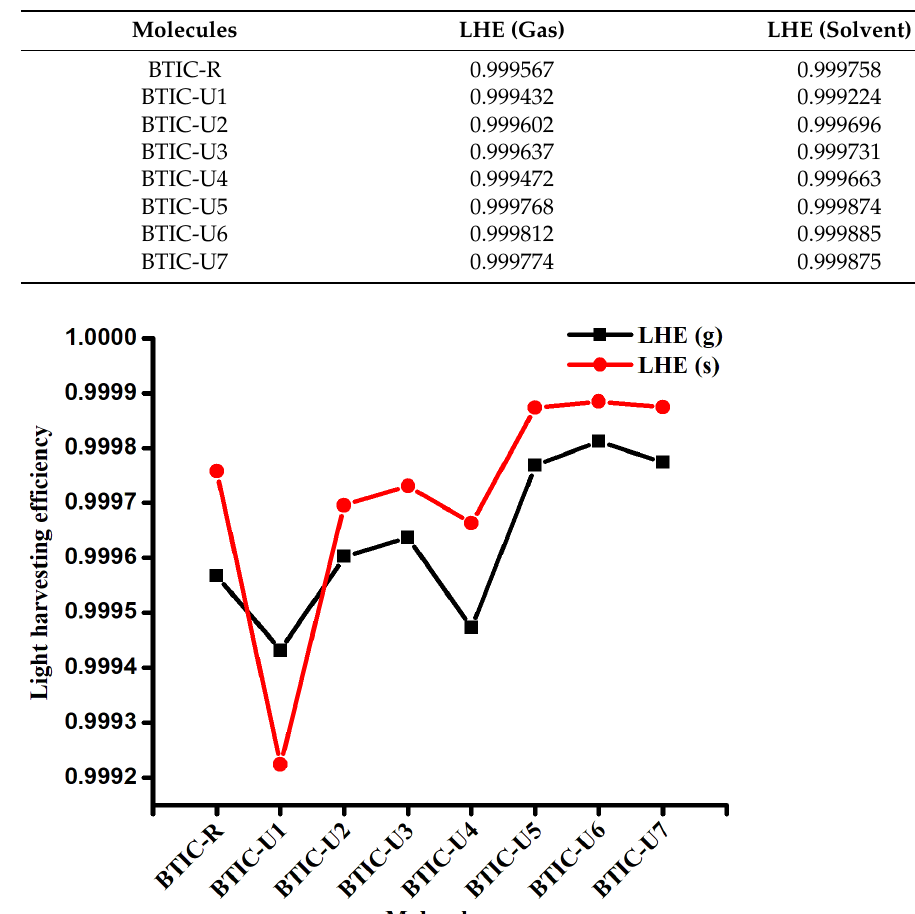
Table 5. Dipole moment ( μ ) of BTIC-R and BTIC-U1 to BTIC-U7 molecules. Molecules